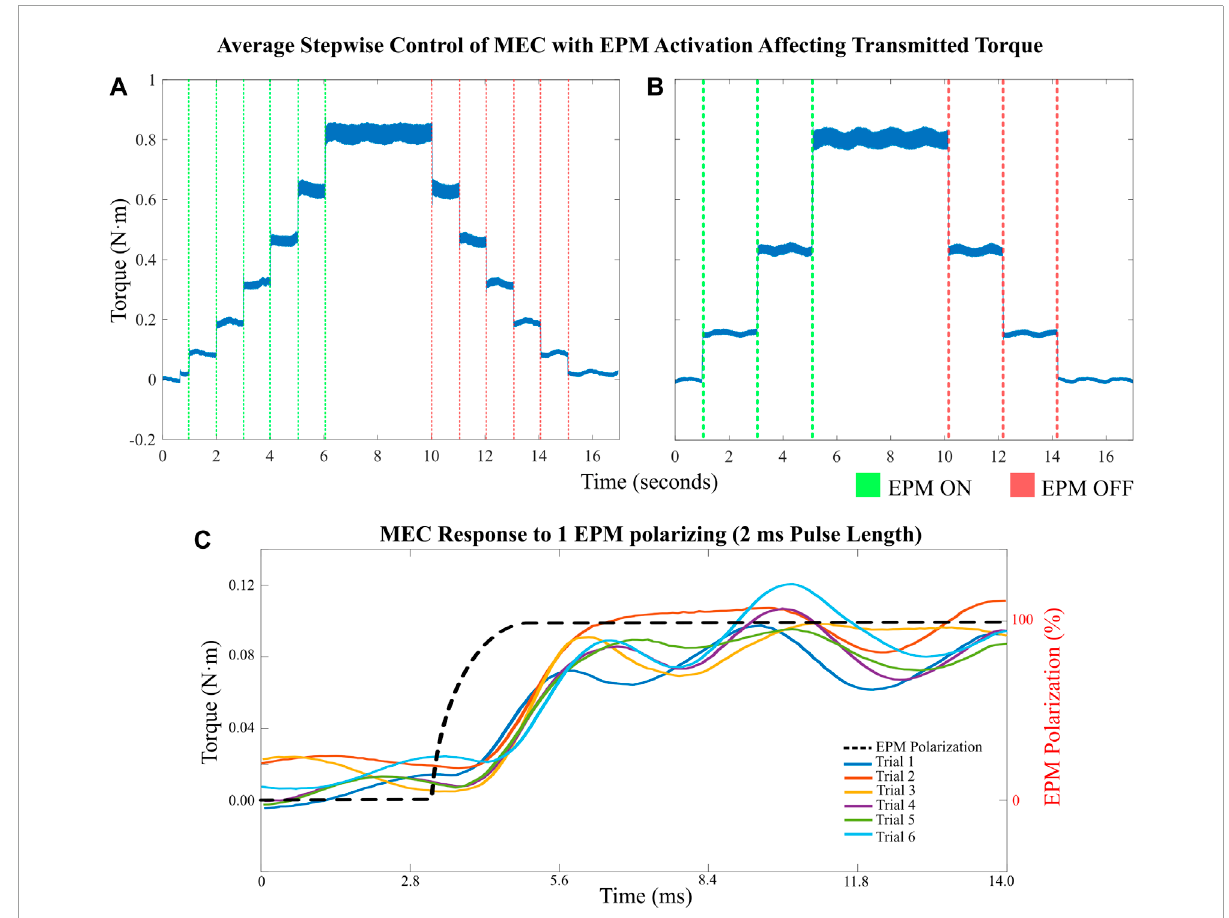
FIGURE 10 Demonstrating step-wise control of the MEC. (A) Each EPM is activated sequentially, resulting in six steps up until being held at the maximum value, before stepping back down to zero. (B) Two EPMs (on opposite sides of the MEC) are activated at once, resulting in larger jumps between each step, but behaving similarly to when single steps are made. (C) Six trials are shown where a single EPM is activated, resulting in a jump in the transmitted torque. The EPM polarization length was 2 ms, and the response of the MEC closely adheres to the EPM magnetization with a delay of about 1